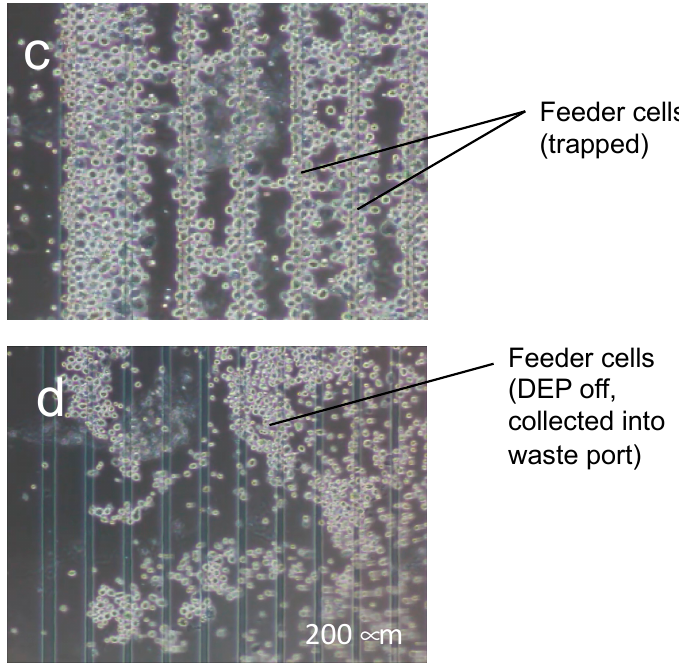
Figure 8. Purification of mESCs (ES-B3) from the ES/feeder cell-mixed suspension using DEP and fluid-flow control. ( a ) Injection of mixed-cell suspension; ( b ) Trapping of MEF cells by positive-DEP force and purification of ES-B3 cells from mixed-cell suspension; ( c ) Covering of 80% of the electrode array by MEF cells; ( d ) Release of trapped MEF cells.